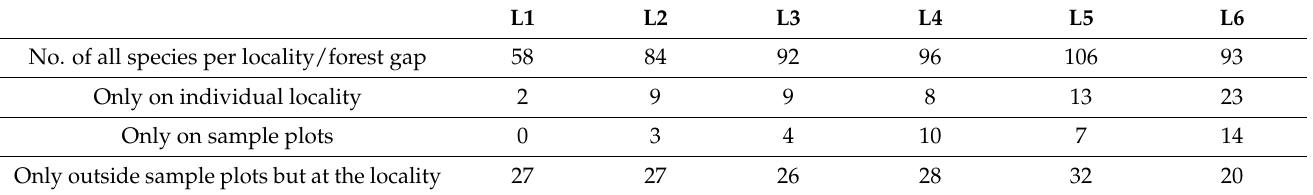
Table 3. Number of plant species at single locality (L1–2000; L2–2007; L3–2007; L4–2013; L5–2011; L6–2014). L1 L2